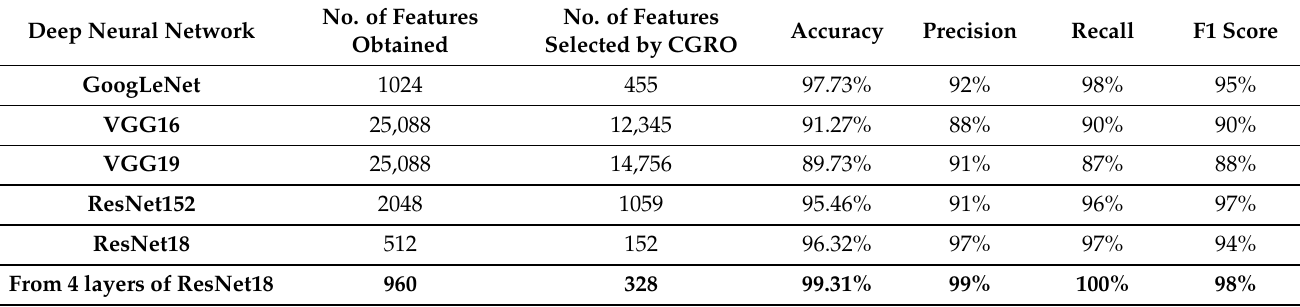
Table 2. The results obtained on Covid CT-Dataset using different models. Different parameters and obtained results with 4 layers features of ResNet18 are highlighted boldly in the